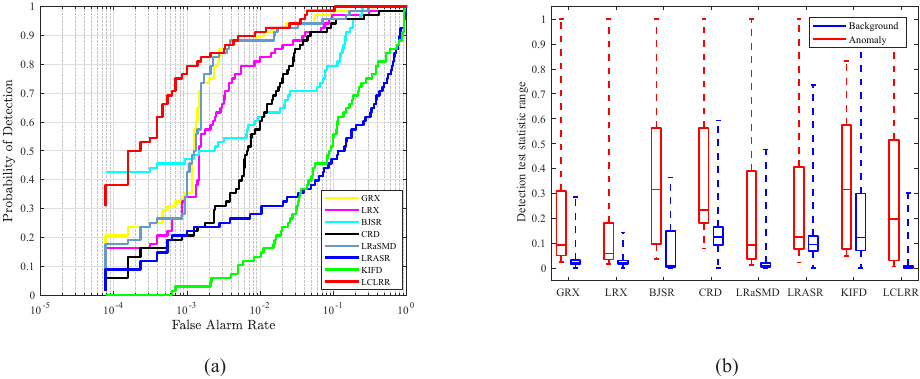
Figure 8. The ROC curves and box plots of different algorithms for the Pavia center dataset. ( a ) ROC curve. ( b ) box